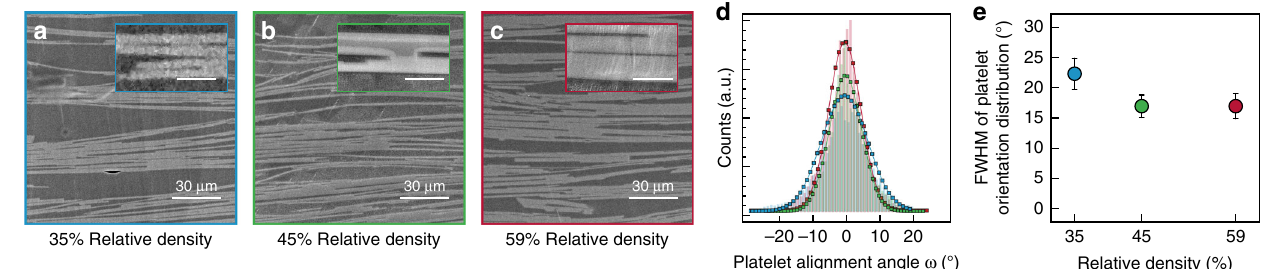
Fig. 2 Microstructural analysis of the transparent and tough nacre-like composites. a – c Scanning electron micrographs of the polished cross sections of composites with relative densities of 35 ( a ), 45 ( b ), and 59% ( c ). Insets of a – c show details of the mineral bridges. Insets scale bars: 3 µ m. d Distribution of alignment angles of the glass platelets in the three different microstructures. Gaussian distributions are used for fi tting the data obtained using image analysis. e Full width at half maximum (FWHM) of the different angle distributions. At least ten images were used in the analysis of each scaffold density. The error bar represents the measured standard